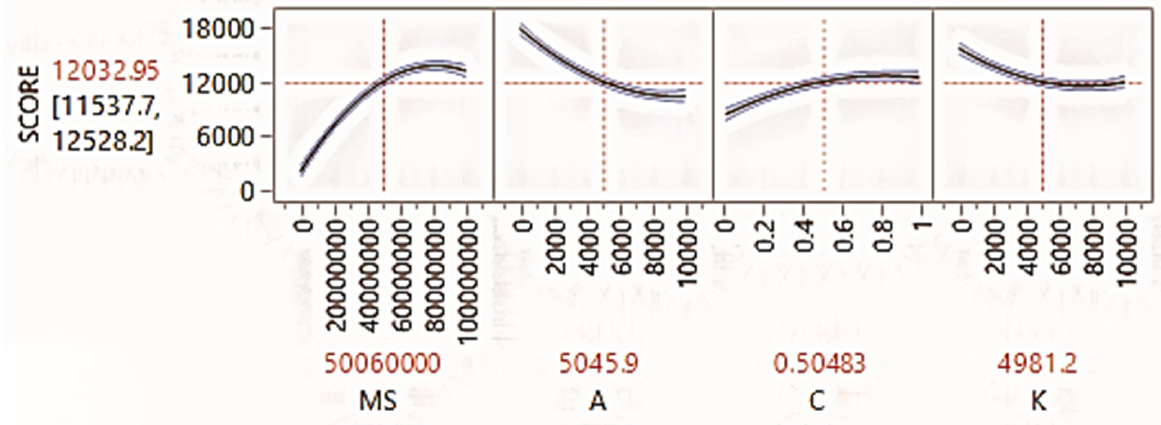
Figure 4. Prediction profiler for the response surface model.